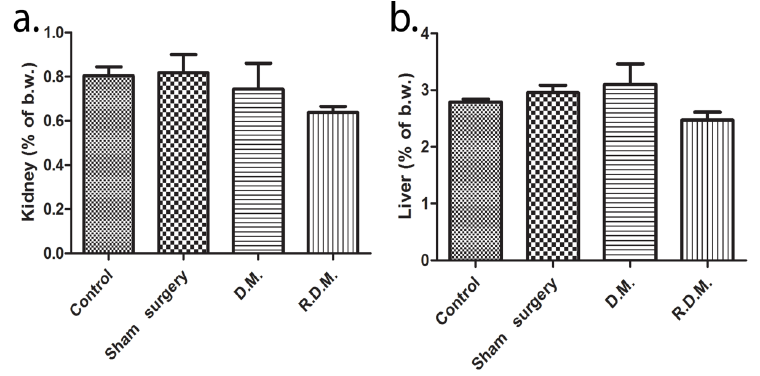
Figure 5. Changes in relative organ weight. ( a ) Kidney, ( b ) liver, (% of body weight), (one-way ANOVA test, post hoc Dunnett’s range test, n = 5). Graphene dental materials treatment significantly increased the level of serum calcium (Ca) (LC1: 15.5 ± 0.4) (p < 0.001) (GZ2: 14.1 ± 2.3) (p < 0.05) compared to the control group (10.4 ± 0.5).